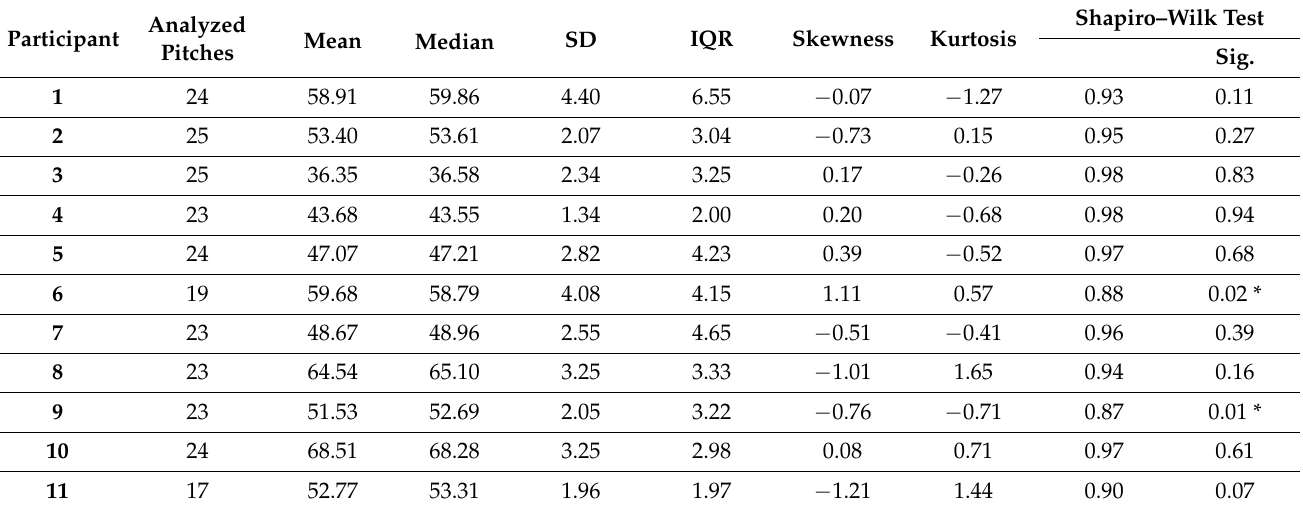
Table 1. Descriptives of the set of scores for each participant for their series of (peak) external elbow valgus torque. The two columns on the right show the results of the Shapiro–Wilk test. SD = standard deviation; IQR = inter quartile range; * =